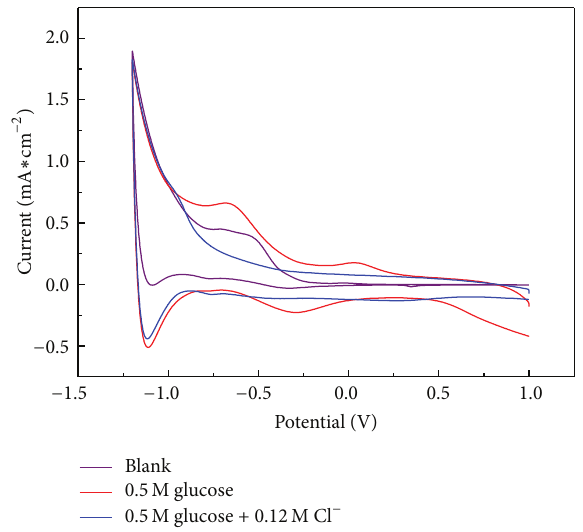
Figure 5: CVs of Ag-TiO 2 (500 ∘ C) nanotube electrode in blank solution, 0.5 M glucose with the presence of 0.12 M NaCl and 0.5 M glucose without the presence of 0.12 M NaCl supported by 0.1M neutral PBS.